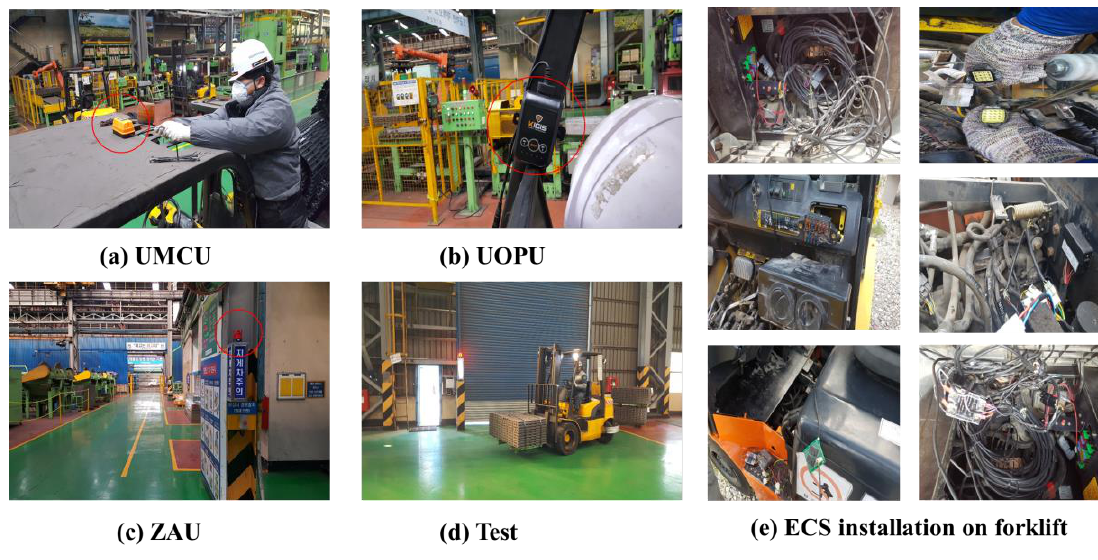
Figure 23. Field experiment environment (industrial